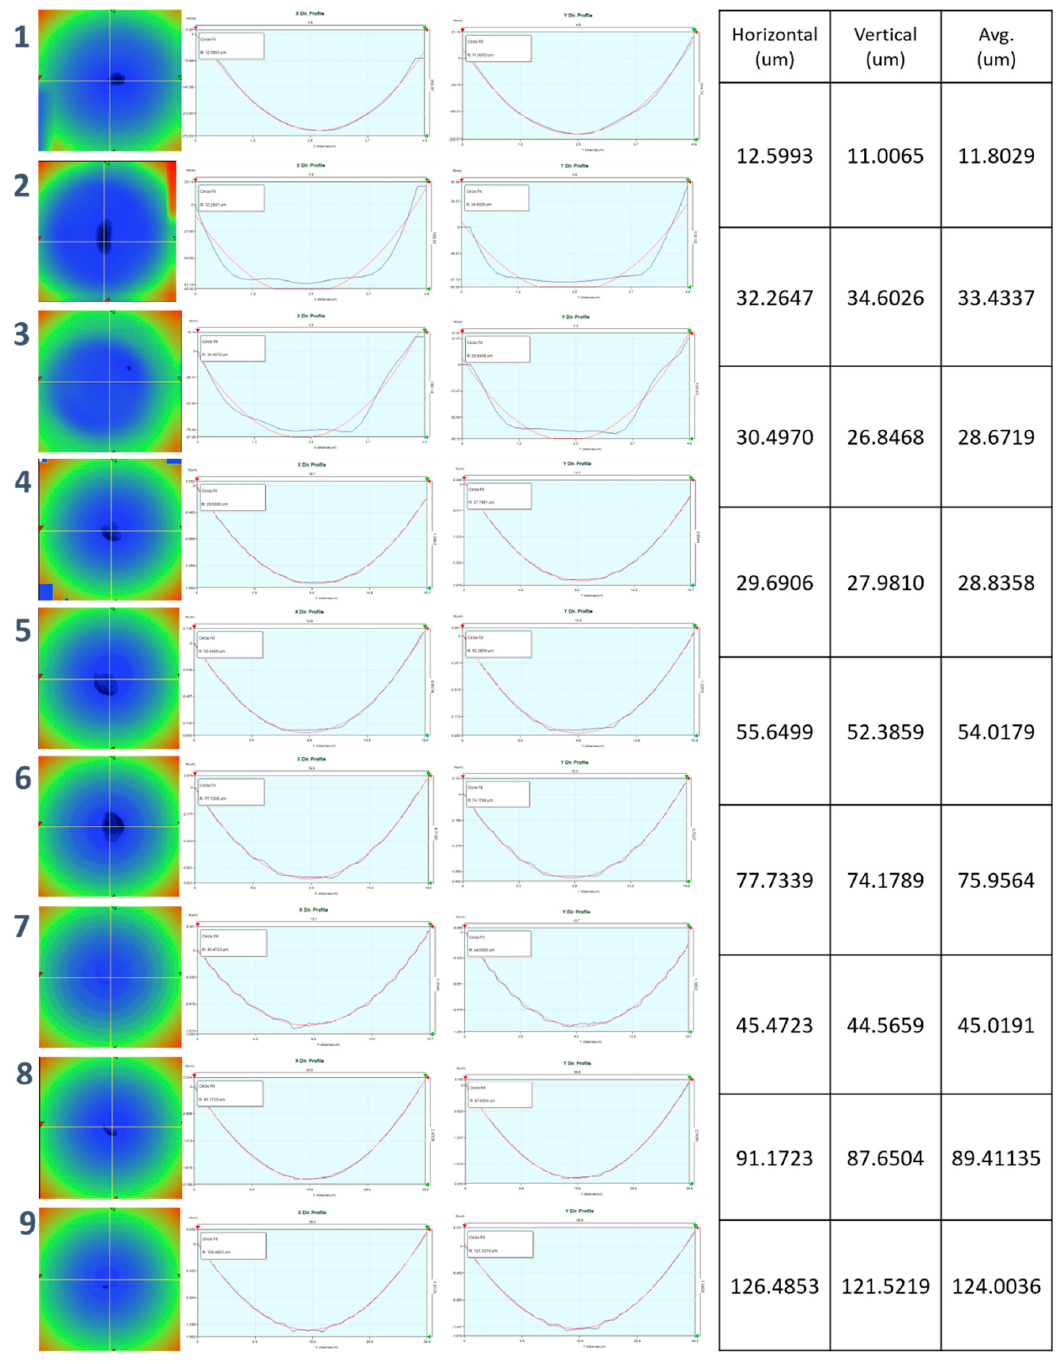
Figure A19. ROC measurement data for 5th final product replica (OrmoComp).